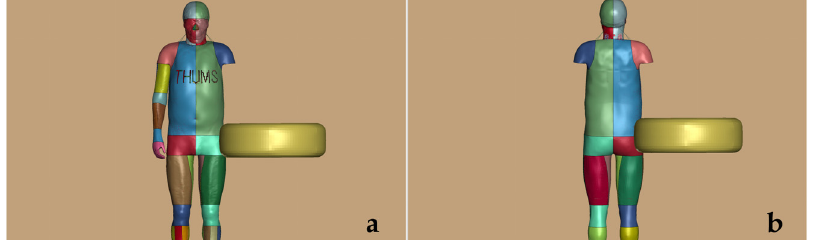
Figure 5. Pelvic run-over loading conditions. ( a ) Front side run-over by a wheel; ( b ) Back side run-over by a wheel.